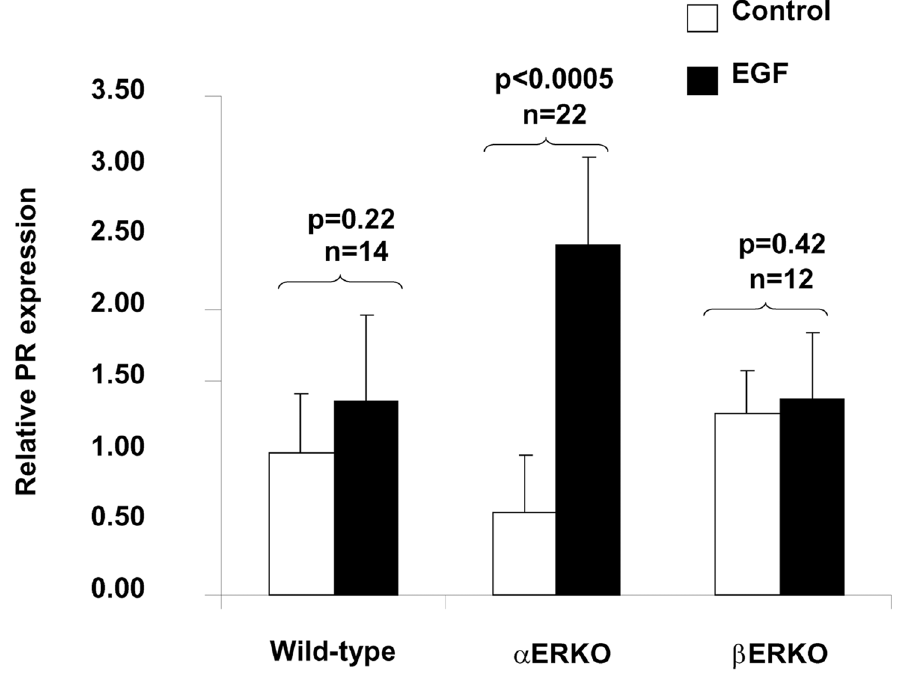
Figure 3. Effect of EGF treatment of mice on the progesterone receptor (PR) mRNA expression in the mammary glands. Mammary glands were isolated from WT, a ERKO and b ERKO mice pretreated with or without EGF (25 ng/mouse/day, 5 days) and homogenized in Trizol (Invitrogen). Total RNA was isolated and subjected to quantitative RT-PCR analysis. Primers were designed to recognize both PR-A and PR-B. PR mRNA levels in the control samples were set as 1 after normalized to the amount of total RNA. The results are expressed as a mean 6 SEM, a ERKO**p , 0.0005 (n=22) in comparison to control, whereas the induction of PR mRNA in WT and b ERKO mice was not statistically significant between EGF treated and untreated glands (one-way ANOVA).